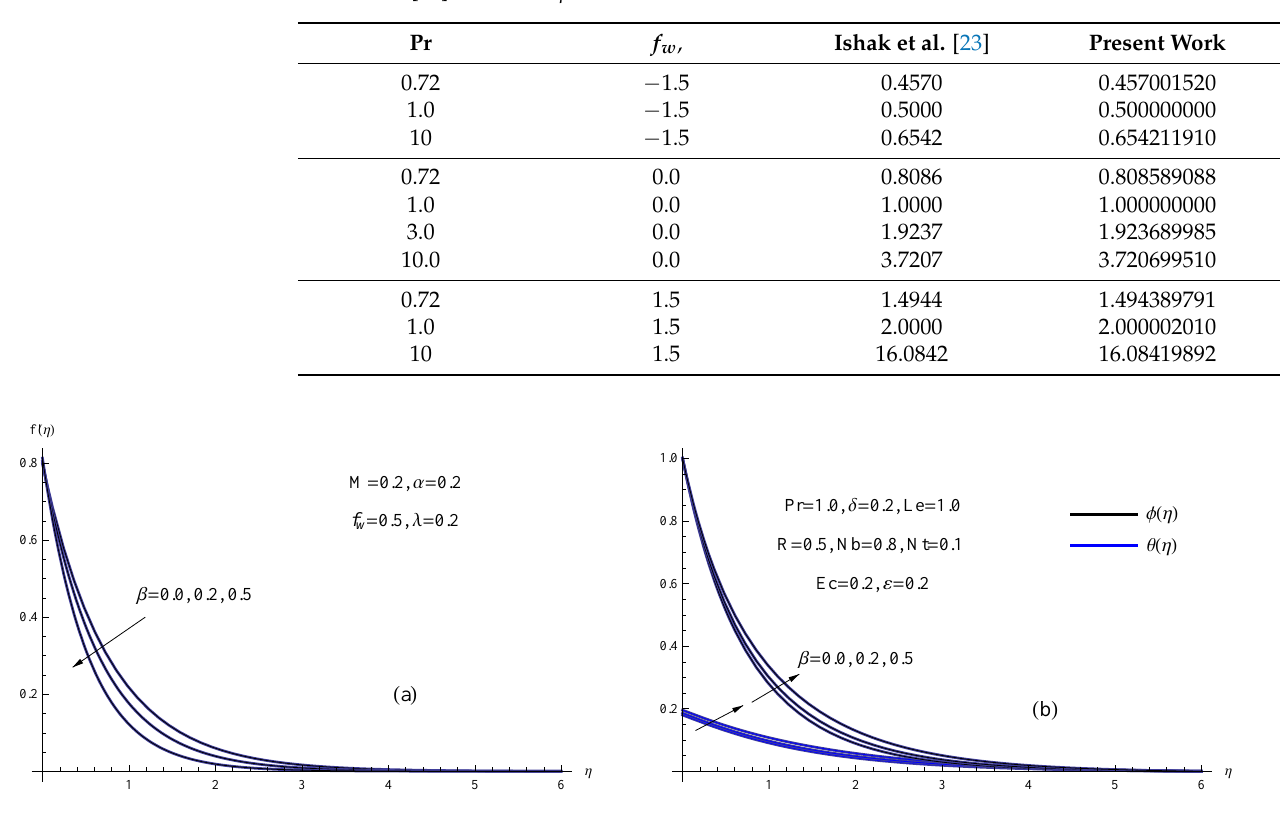
Figure 2. ( a ) The f (cid:48) ( η ) for chosen β , ( b ) θ ( η ) and φ ( η ) for chosen β . According to the change of the suction parameter f w , Figure 3 shows the analysis of the flow and heat mass transportation performance of Maxwell nanofluid. An intriguing finding is that the classical model specifies the lowest fluid flow for high values of the suction parameter while having the fastest velocity profile for low values. Higher suction parameter values lessen the mass distribution while enhancing the cooling of the nanofluid and the sheet temperature θ ( 0 ) since the fluid displays the fastest heat and mass transfer in the absence of the suction parameter (impermeable sheet).